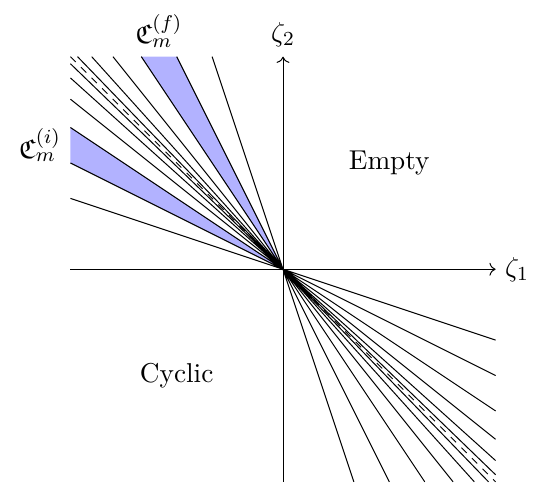
Figure 6 . The stability chambers of the